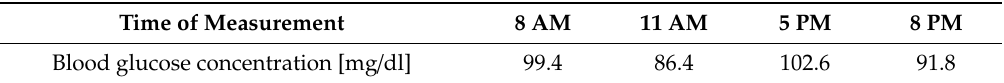
Table 4. Patient’s blood glucose level before treatment in